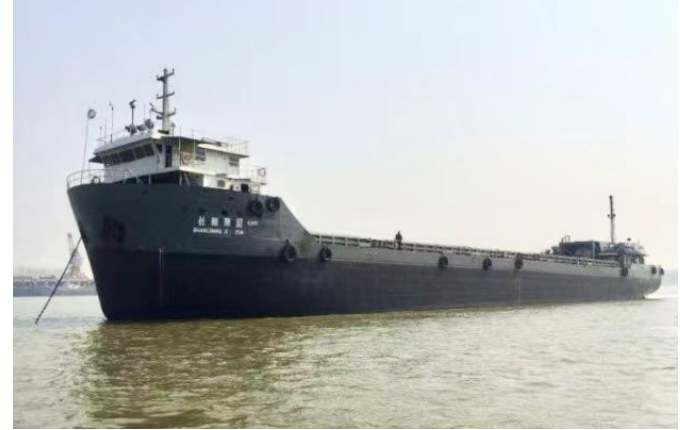
Figure 4. The inland bulk carrier on the Yangtze river. Table 1. Parameters of the target ship.